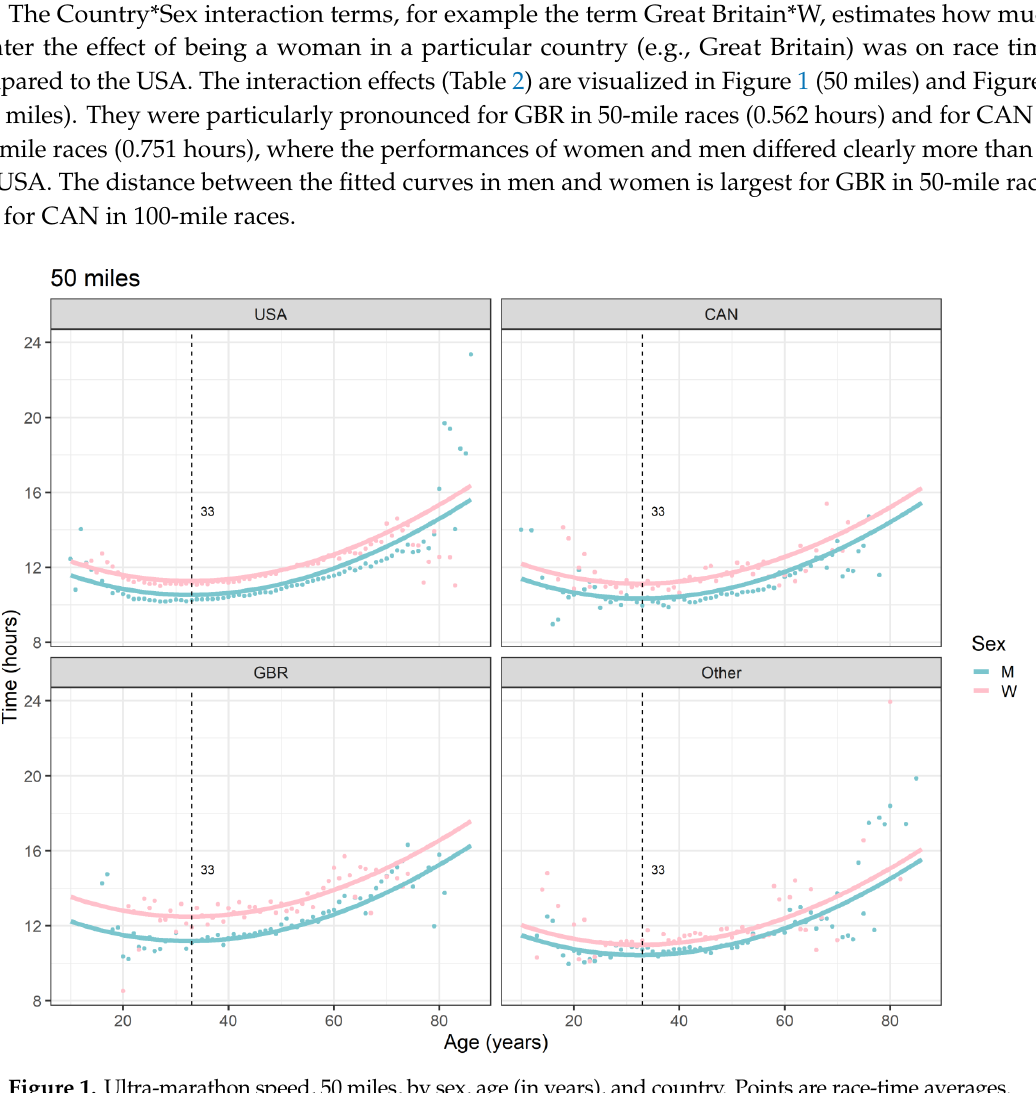
Figure 1. Ultra-marathon speed, 50 miles, by sex, age (in years), and country. Points are race-time averages. Lines are fitted curves (mixed model). Vertical lines with numeric labels are the ages at peak performance. USA = United States of America, CAN = Canada, GBR = Great Britain, W = women, M = men.